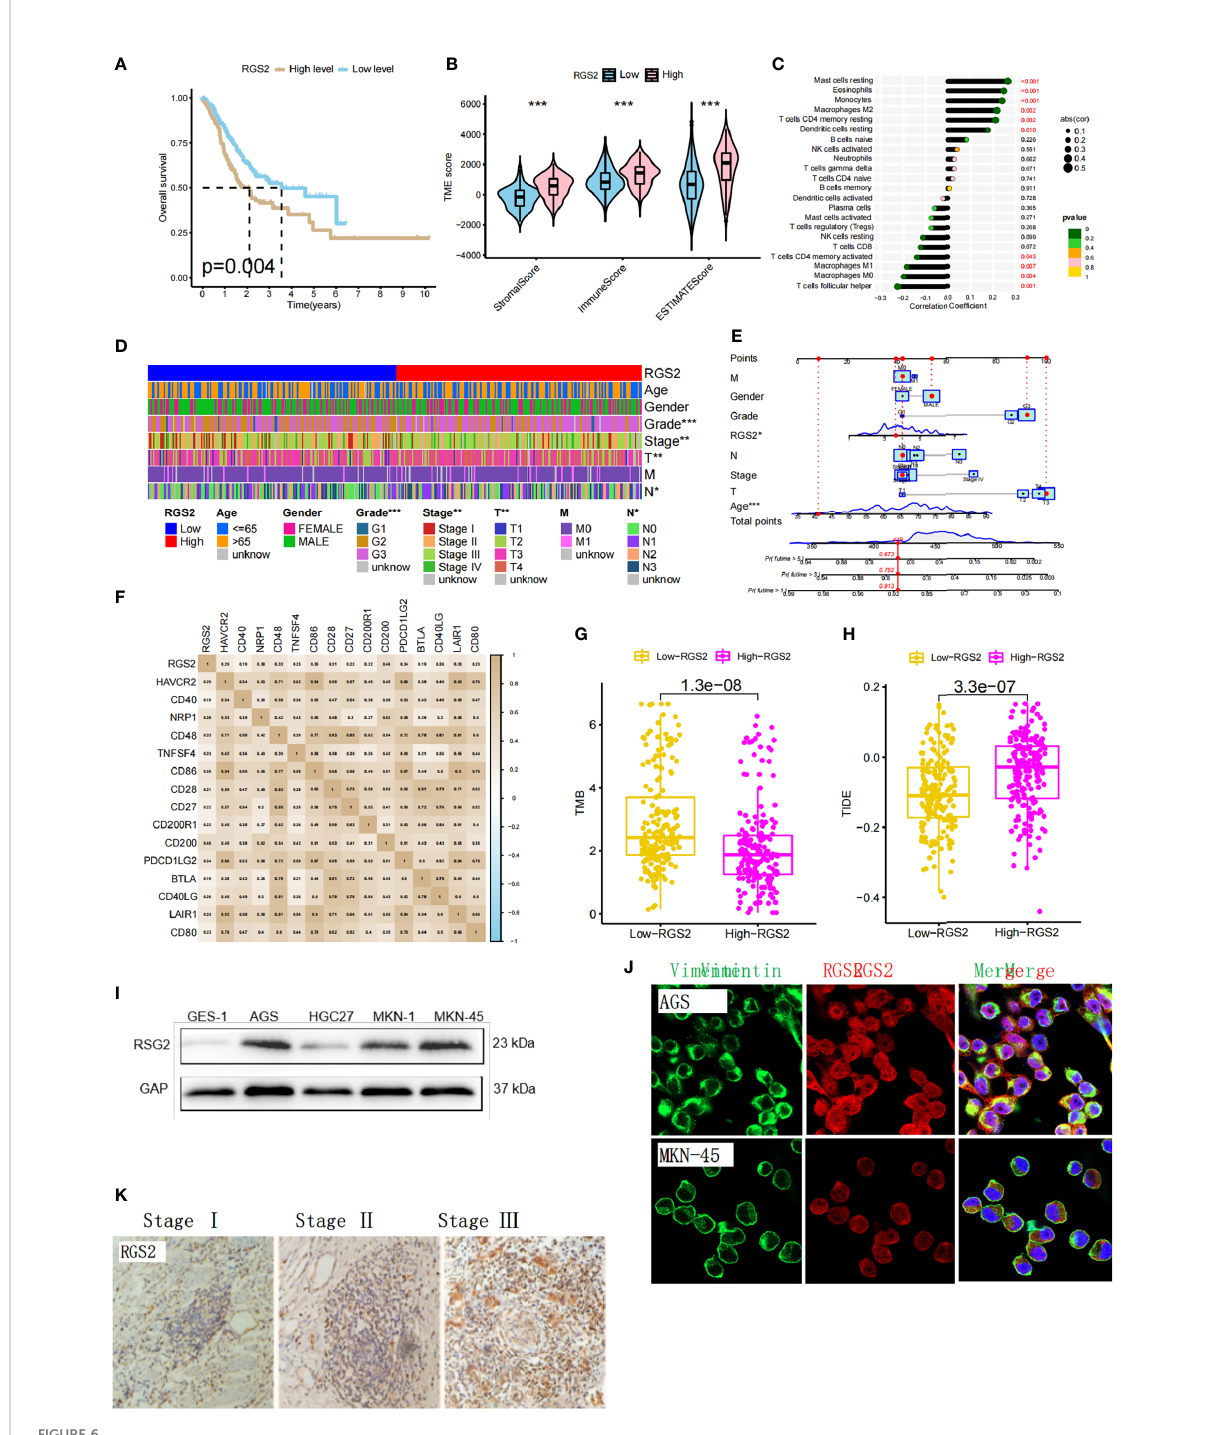
FIGURE 6 Biological signi fi cance of RGS2 in gastric cancer and expression level of gastric cancer cell line (A) The relationship between the high and low expression of RGS2 in gastric cancer and prognosis (B) The relationship between the high and low expression of RGS2 and the score of TME (C) The correlation between the high and low expression of RGS2 and immune cell in fi ltration. (D, E) Analysis of the correlation between the high and low expression of RGS2 and the clinicopathological features of patients (F) The relationship between the high and low expression of RGS2 and immune checkpoints (G) The relationship between the high and low expression of RGS2 and TMB score (H) The relationship between high and low expression of RGS2 and TIDE score (I) Expression at mRNA level of RGS2 in gastric cancer cell lines AGS, HGC27, MKN-1, MKN45 and normal gastric mucosal cells GES-1 (J) Expression and localization of RGS2 in gastric cancer cell lines AGS and MKN45 (K) Expression of RGS2 in different clinical stages of gastric cancer.